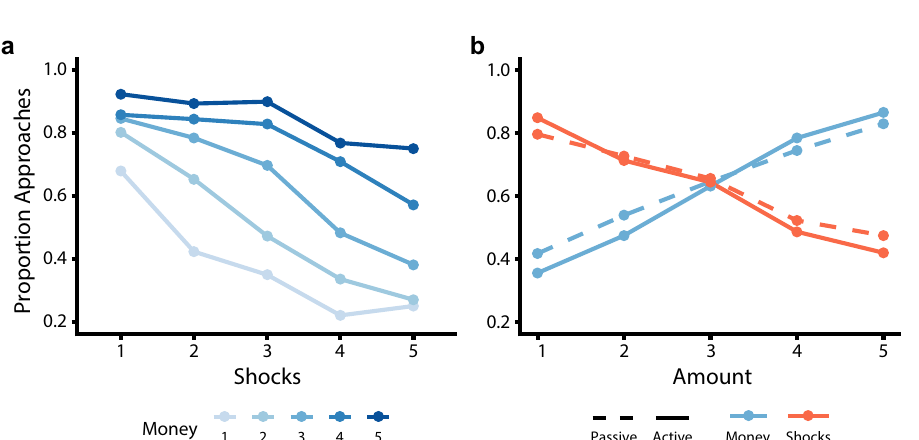
Figure 2. Effects of potential money and shocks and passive/active trial context on the proportion of approach choices. ( a ) Participants approach more with higher money amounts, and approach less with higher shock amounts. ( b ) Moreover, approach choices are more often active with increased money amounts and more often passive with higher shock amounts. Line types reflect active (solid) versus passive (dashed) approach